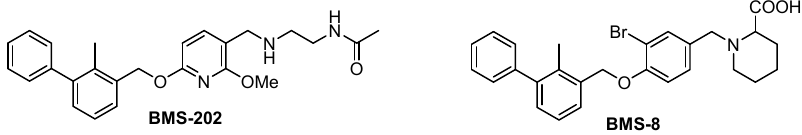
Figure 1. Non-peptidic small molecules able to interact with PD-L1.